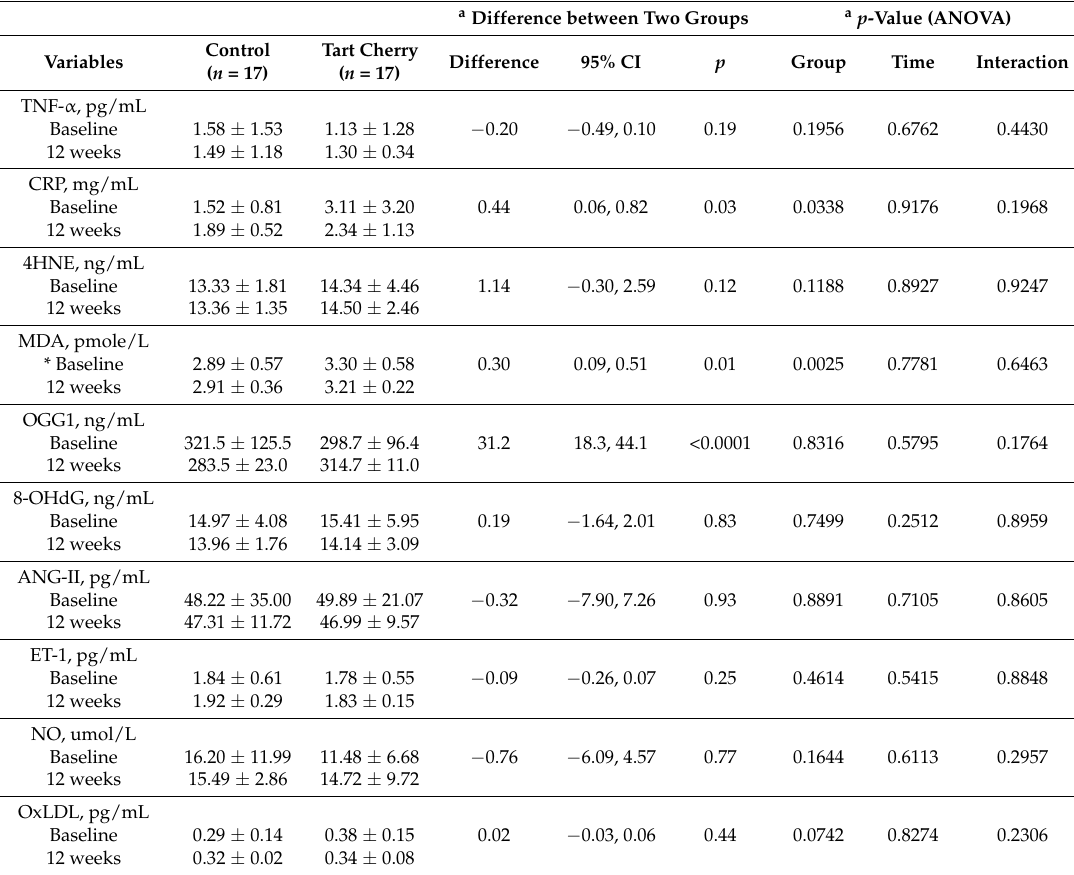
Table 1. Blood biomarkers of inflammation and oxidative stress in older adults at baseline and 12 weeks after supplementation with tart cherry juice or control drink. a Difference between Two Groups a p -Value